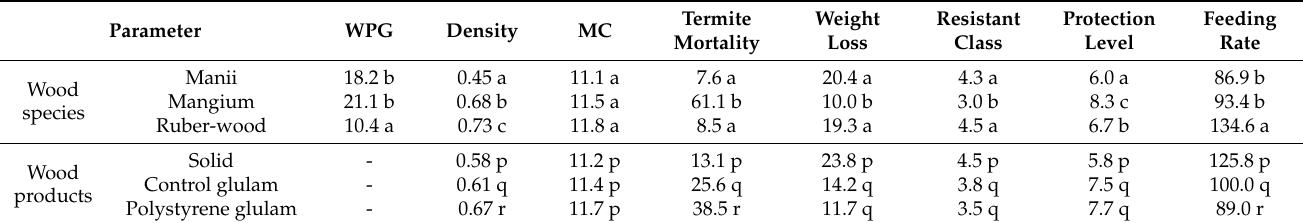
Table 5. Duncan’s multi-range test of physical properties and laboratory termite